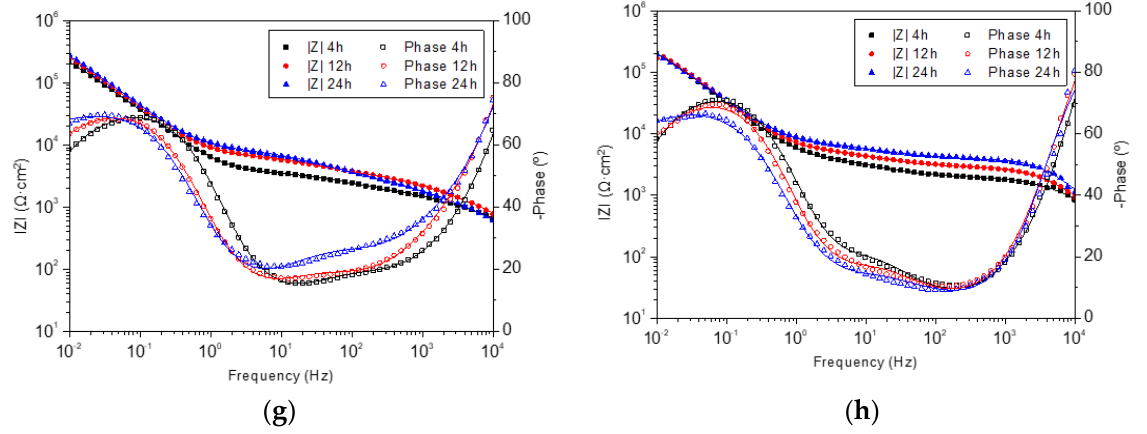
Figure 2. Evolution of Bode spectra with the exposition time on EIS tests. ( a ) Control, ( b ) lc.FOX, ( c ) mc.FOX, ( d ) hc.FOX, ( e ) lc.LNZ, ( f ) mc.LNZ, ( g ) hc.LNZ, and ( h ) hc.FOX-LNZ.